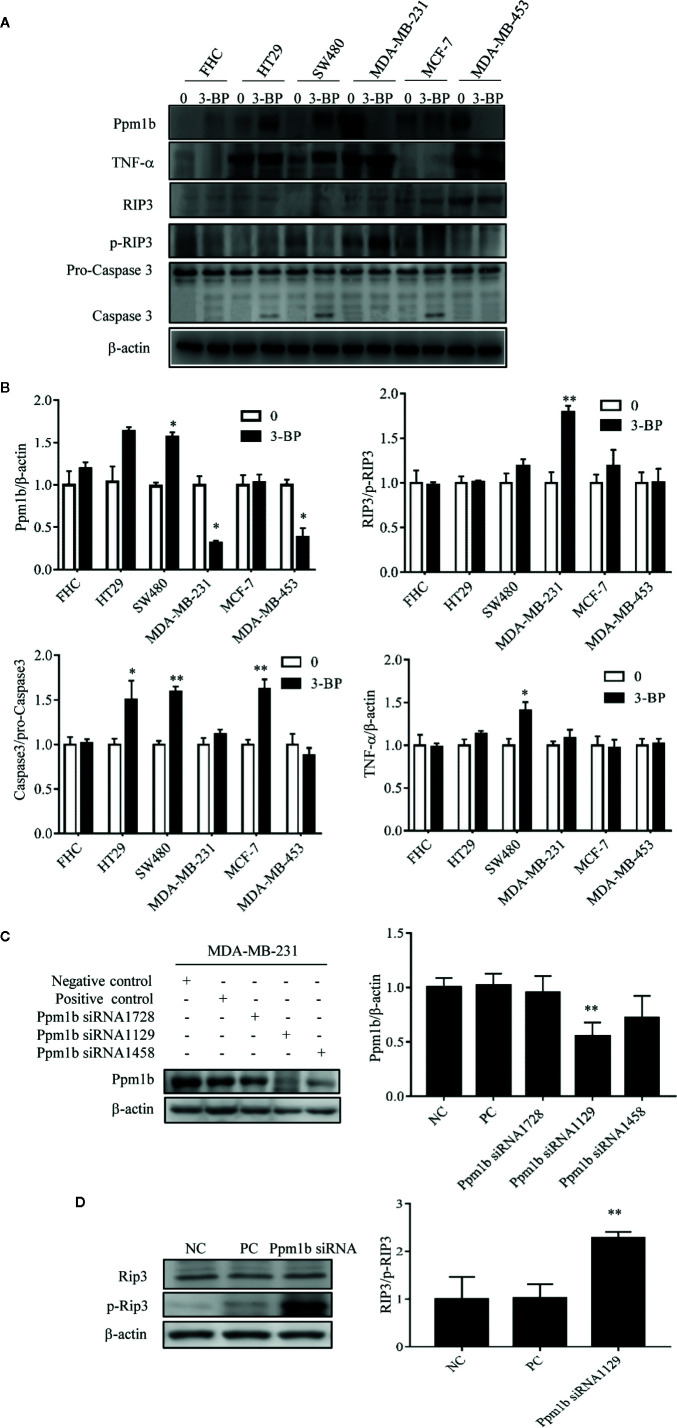
Ppm1b negatively induced necroptosis by dephosphorylation-RIP3. (A, B) MDA-MB-231 cells were treated with 3-BP (0, 160 μmol·l-1), Protein expression of Ppm1b, TNF-α, RIP3, p-RIP3, Caspase 3, and β-actin were analyzed by western blotting. β-actin served as the loading control. (C, D) MDA-MB-231 cells were transfected with siRNA against Ppm1b, then Ppm1b and p-RIP3 were analyzed by western blotting. β-actin served as the loading control. *P < 0.05; **P < 0.01.